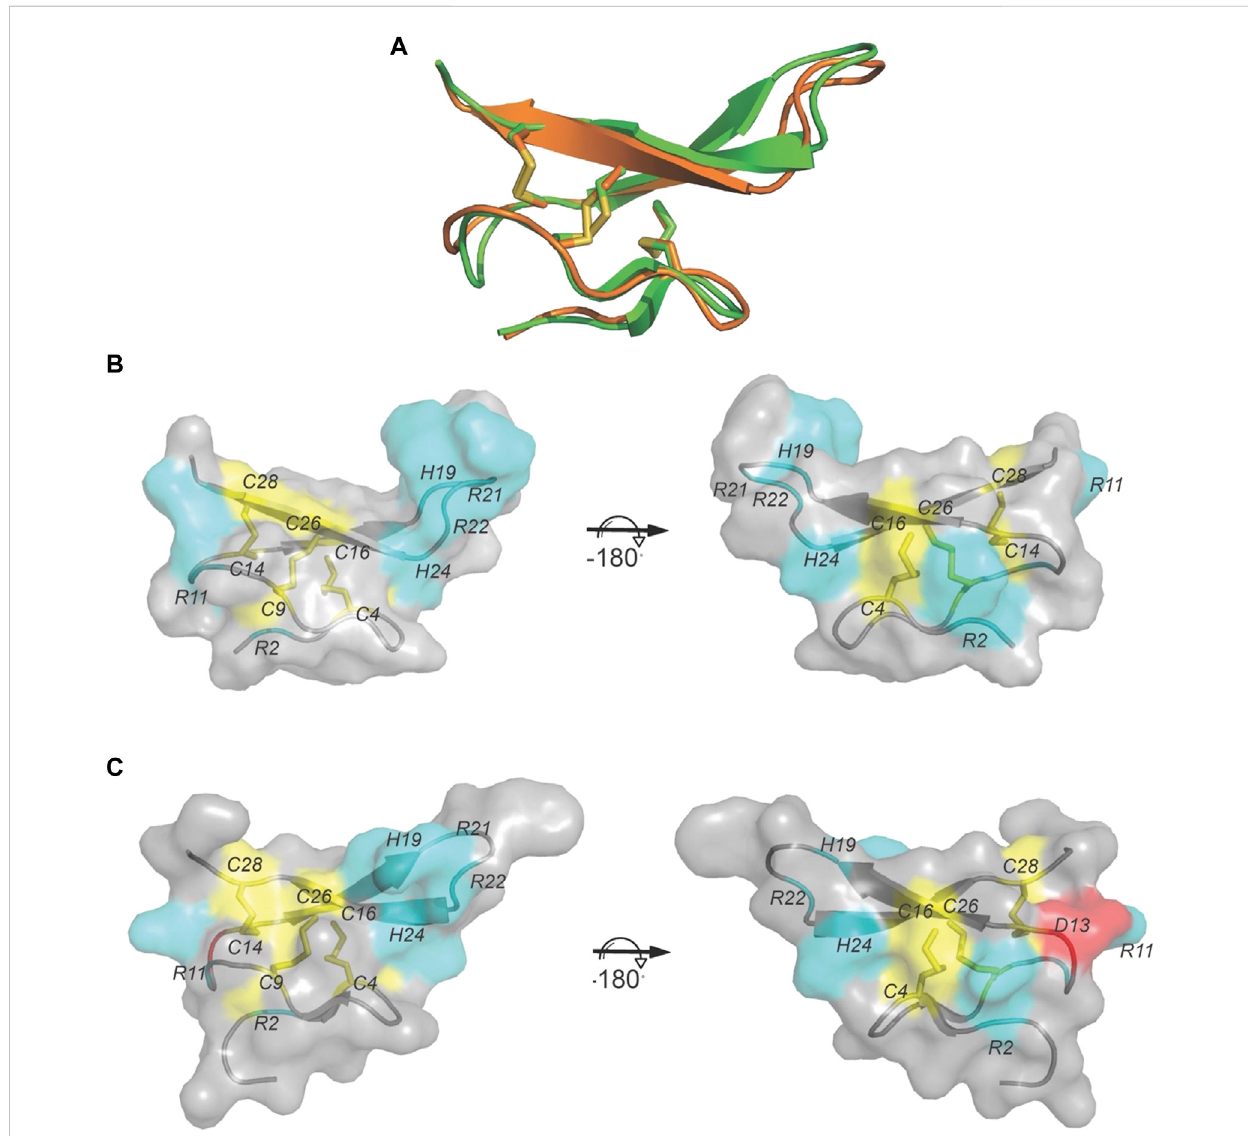
(Figure 5Bi). In contrast, the equivalent surface on the α 3 β 4 nAChR model comprises negatively charged D187, positively charged K189, polar N191 and hydrophobic I188 and Y190 (Figure 5Ci). At the complementary binding face few major contacts were identi fi ed between VxXXB-C(21 – 50) and human α 7 nAChRs, although these surfaces are comparable to the polar (Q57, L109, and Q117) and hydrophobic (W55, L119, and Y168) surfaces of Ls -AChBP (Figure 5Bii). At α 3 β 4 nAChRs, the corresponding surface is strongly hydrophobic except for the positively charged K61, which may introduce a cation- π interaction with VxXXB-C(21 – 50)_W19 (Figure 5Cii).